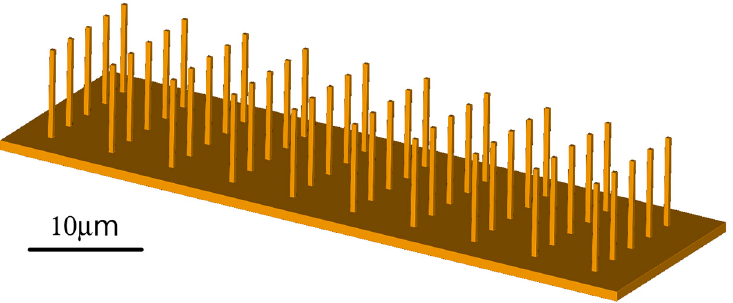
Figure 11. A MEMS contains a cluster of micro-sized elastic beams with different properties and appropriate electronics for wireless data transfer.